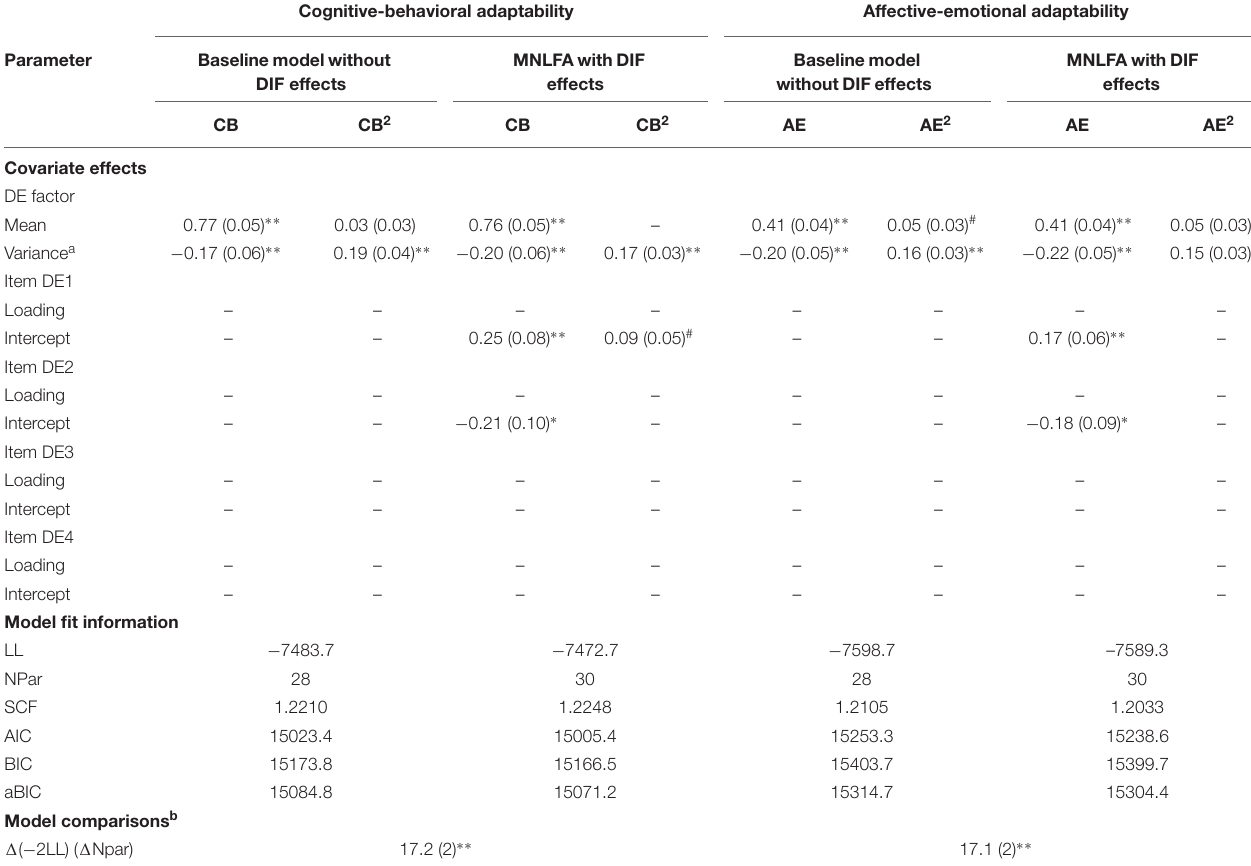
TABLE 2 | Unstandardized parameter estimates from the MNLFA models with adaptability as